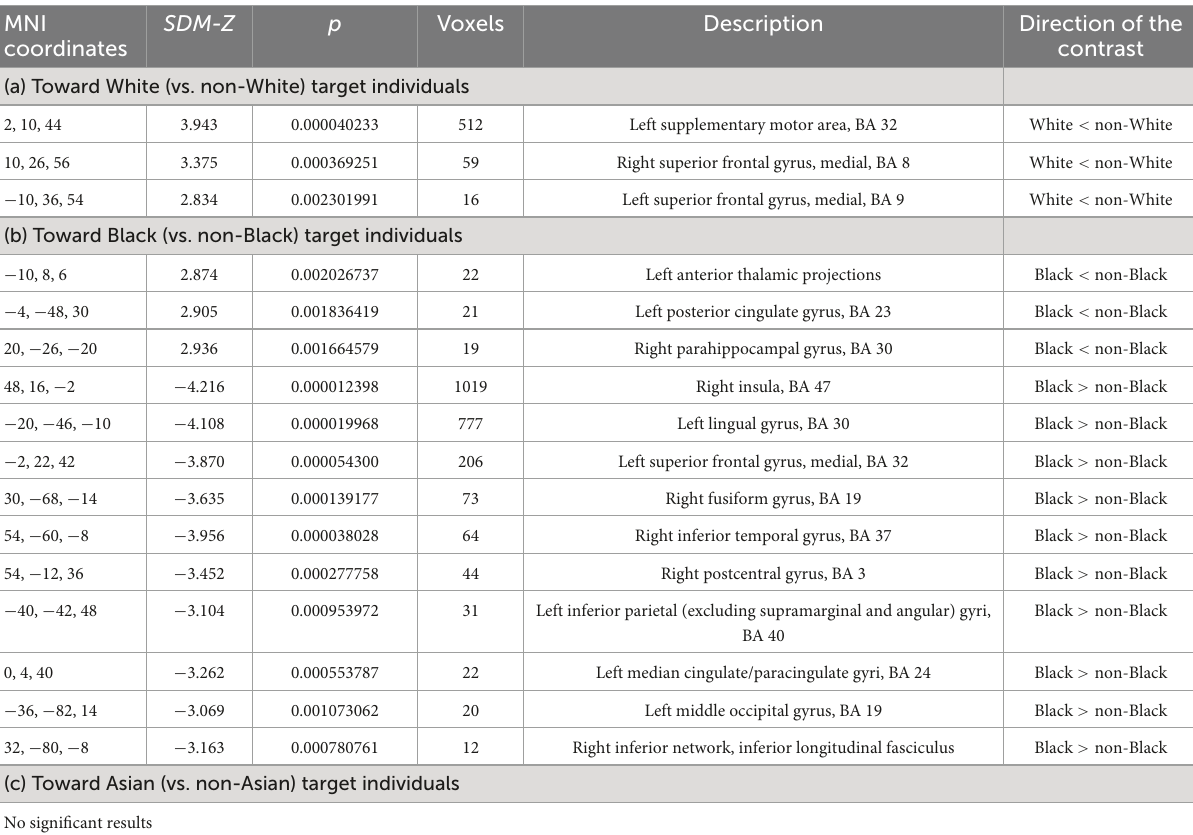
TABLE 2 Neural inter-group bias (a) toward White (vs. non-White) target individuals, (b) toward Black (vs. non-Black) target individuals, and (c) toward Asian (vs. non-Asian) target individuals. MNI SDM-Z p Voxels Description Direction of the coordinates